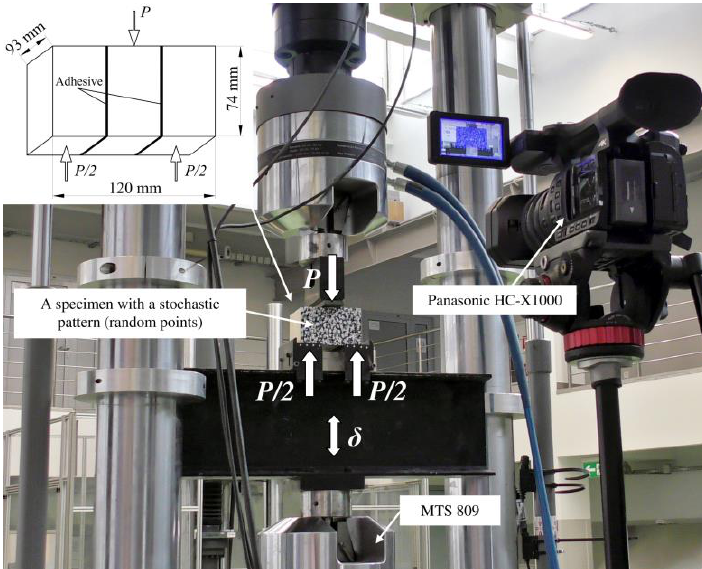
Figure 10. Laboratory setup of a double-lap shear test.